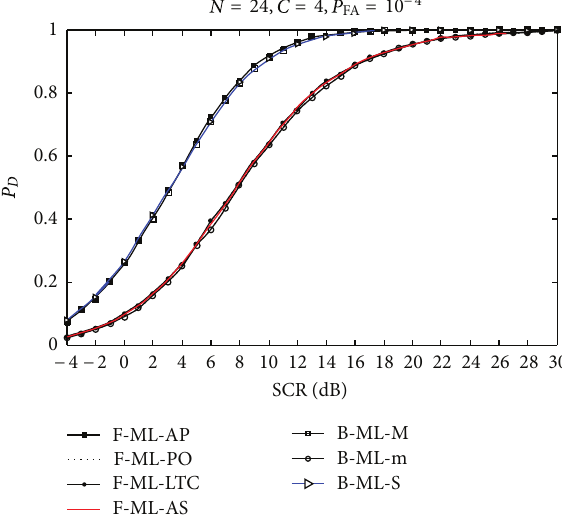
F 2: PD versus SCR performance of distributed detector based on OS CFAR algorithm in local sensors when